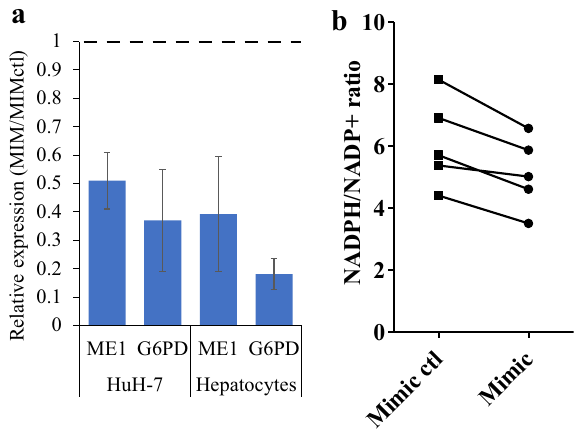
Figure 4. miR1908-5p mimic reduces ME1, G6PD and the NADPH/NADP+ ratio. Lysates from HuH-7 cells and primary hepatocytes treated with miR1908-5p or control were assayed for the presence of a, G6PD, ME1 by qRT-PCR or b , NADPH and NADP+. In ( a ) MIM vs MIMctl differences were all statistically significant (Student’s t-test < 0.05). In ( b ) Matched samples from each biologic are linked by a line. Treatment with miR1908-5p was associated with a reduction in the ratio of NADPH/NADP+ (0.84 ± 0.06; p = 0.007, paired